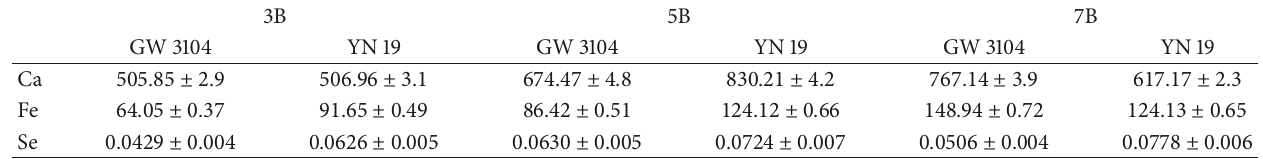
Table 4: Microelement contents of different wheat milling methods